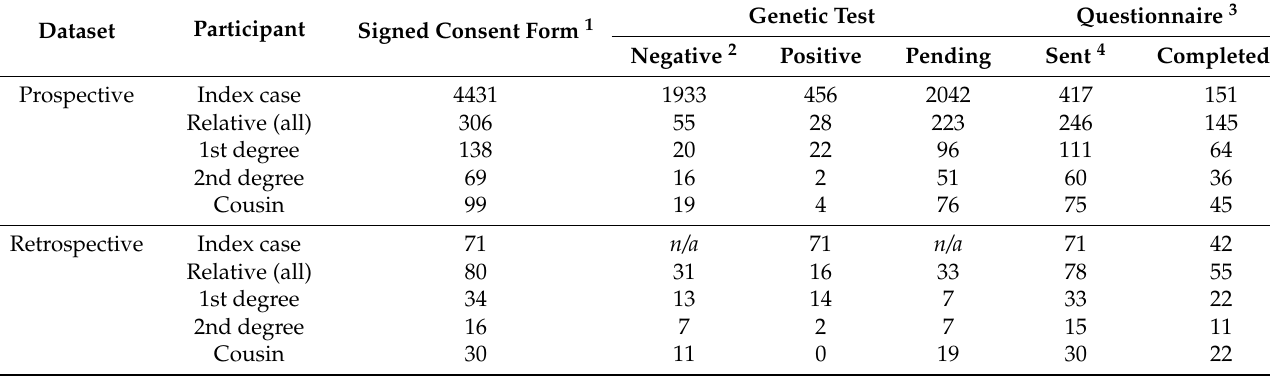
Table 1. Available data per type of